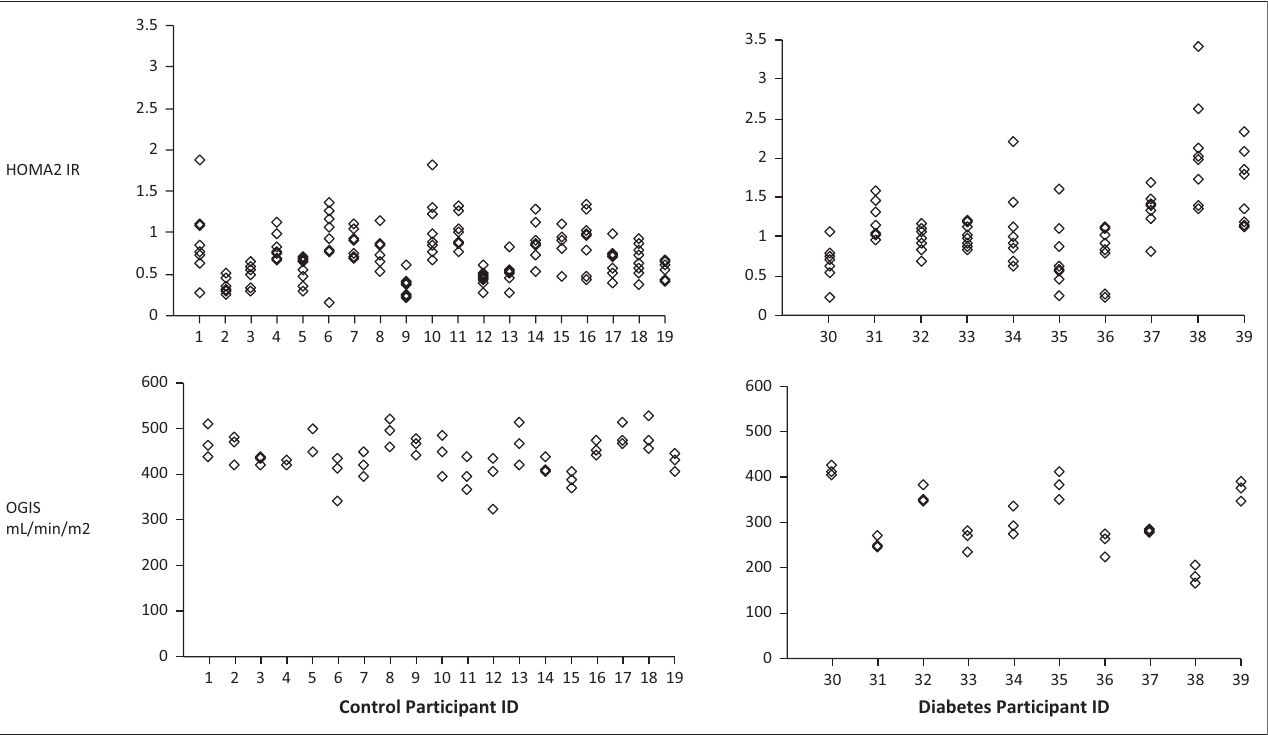
FIGURE 2 (Continues...): Raw data for control (left) and diabetes (right) groups for fasting glucose, fasting insulin, HOMA2 % B, HOMA2 % S, HOMA2 IR and OGIS. TABLE 1: Regression coefficient and p -value for mean–variance relationships. Variable